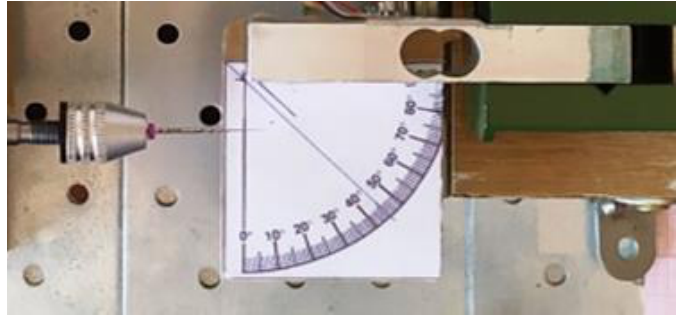
Figure 2. Mobile device with protractor for calculation of the bending angle.